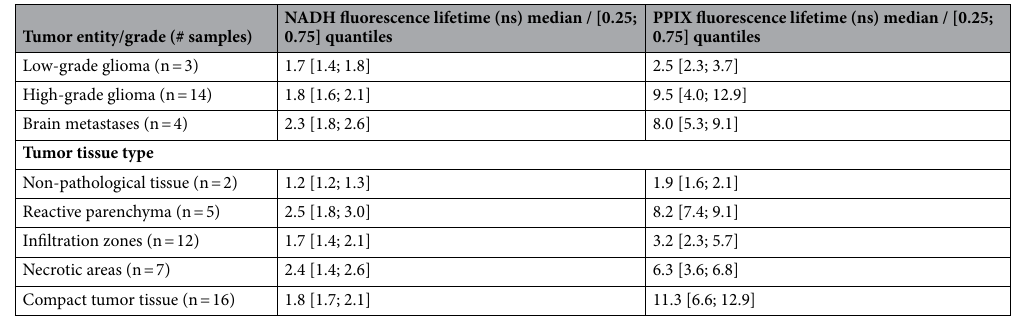
Table 2. Descriptive statistics of the NADH and PPIX fluorescence lifetime depending on tumor entity and tissue type. The table shows the median as well as 25 and 75% quantiles of the NADH/PPIX fluorescence lifetime values measured from the 42 samples. Note that we randomly selected 100 values in each fluorescence lifetime map to compensate for different sized samples. Pathological tissue exhibited increased fluorescence lifetimes for both NADH and PPIX compared to non-pathological tissue. Similarly, low grade gliomas showed reduced lifetimes in contrast to brain metastases and high grade gliomas.